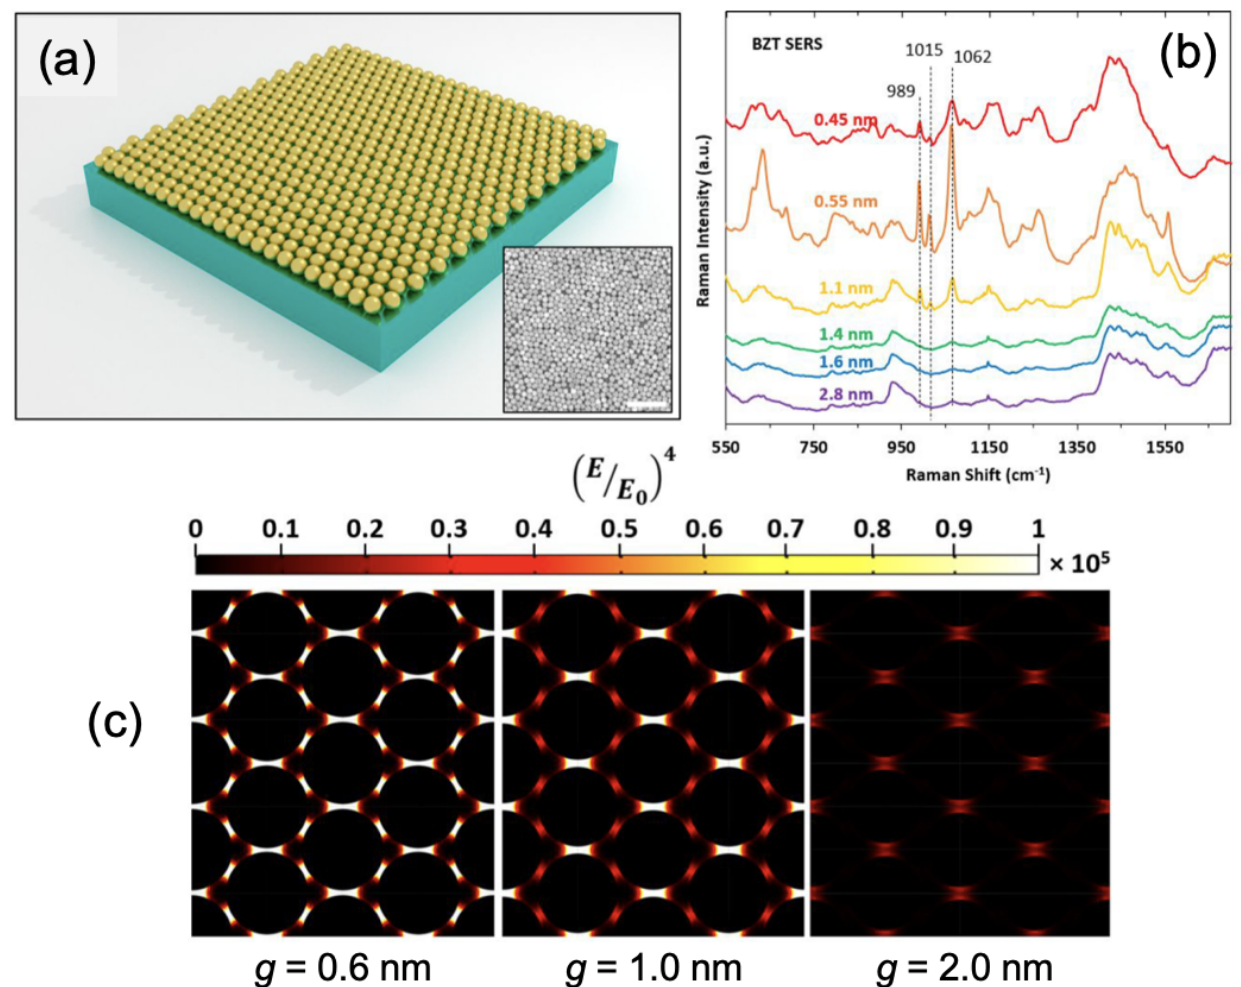
Figure 3. ( a ) Illustration of the plasmonic metasurface composed of gold nanospheres self-assembled on silicon substrate. Inset corresponds to a TEM picture of the plasmonic metasurface with gaps of 0.55 nm (white bar = 100 nm) ( b ) SERS spectra of benzenethiol adsorbed on the metasurface with different values of nanogap. ( c ) Mappings of the electric field enhancement for three values of nanogap (g = 0.6 nm, 1.0 nm and 2.0 nm). All the figures are reprinted (adapted) with permission from [75], Copyright 2022 American Chemical